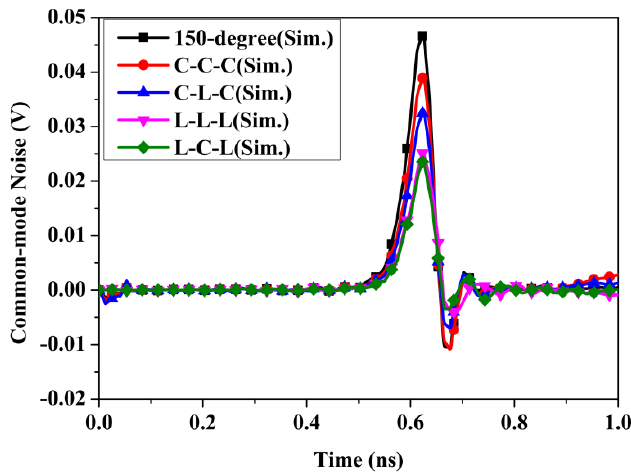
Figure 12. The simulated results of common-mode noise.